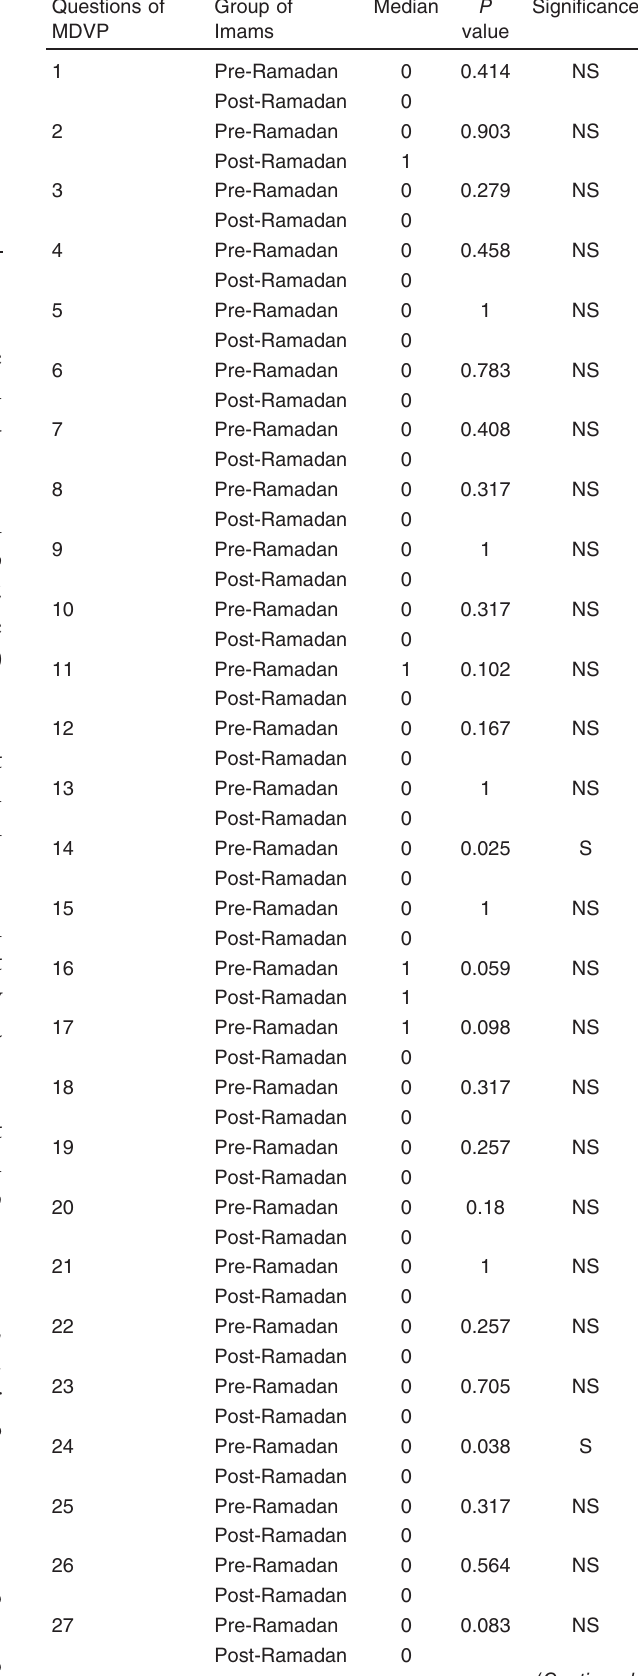
Table 9 Comparison between the results of pre-Ramadan and post-Ramadan assessments for VHI parameters in the group that received the voice hygiene